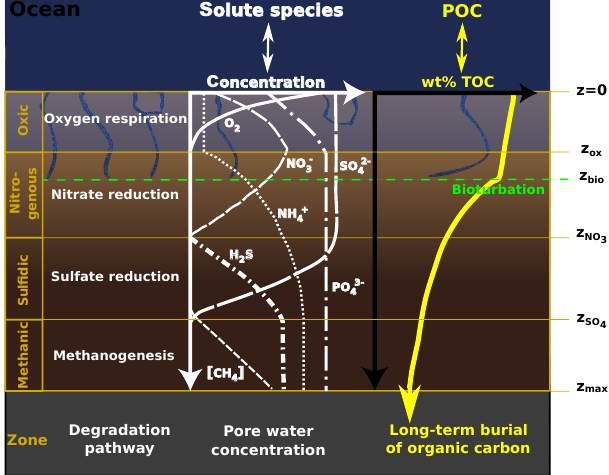
Figure 1. Schematic of the different modelled species and zones in OMEN-SED. Here the case z ox < z bio < z NO